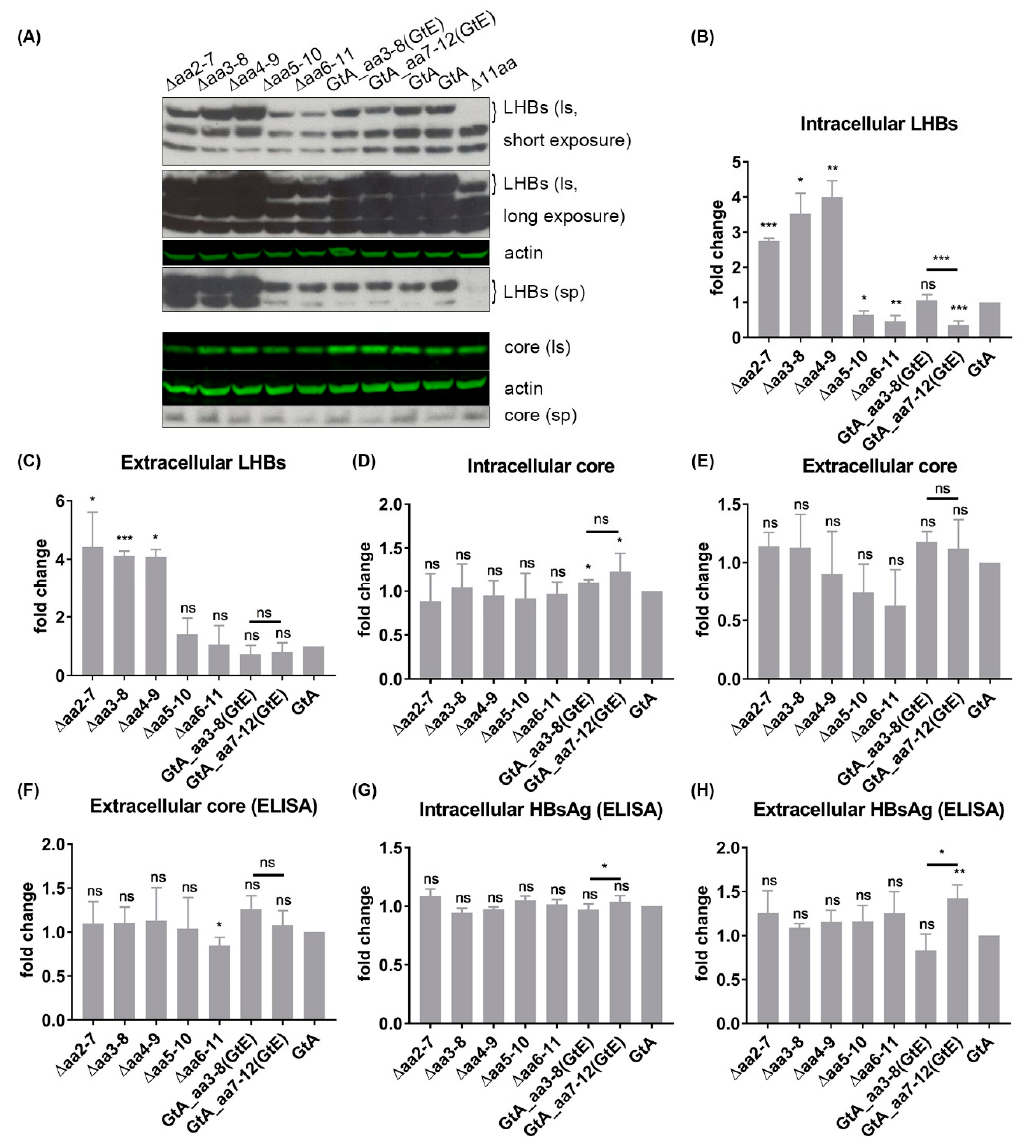
Figure 6. The GtA-derived 11 aa comprise a positive and a negative region regulating LHBs production and secretion. ( A ) Supernatants and lysates from Huh7.5 cells transfected with genomes GtA and the derivatives were analyzed by Western blot using a PreS1-specific serum (MA18 / 7) and a core-specific serum (K46). β -actin was used as loading control. ( B – E ) The signals of LHBs and core in the Western blot were quantified by Image studio lite from LI-COR Biosciences. ( F ) Supernatants from Huh7.5 cells transfected with genomes GtA and the derivatives were analyzed by core ELISA. ( G , H ) Supernatants and lysates from Huh7.5 cells transfected with genomes GtA and the derivatives were analyzed by HBsAg ELISA. The signal from GtA was standardized as 1. Ls, lysate; sp, supernatant. These quantitative data are mean values from three independent experiments. *, p < 0.05; **, p < 0.01; ***, p < 0.001.